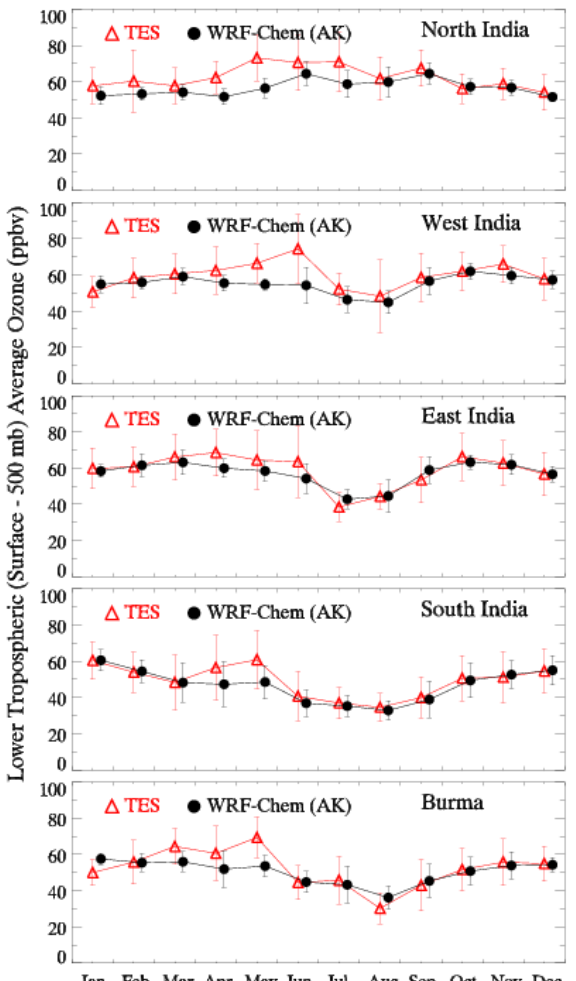
Fig. 8. Seasonal variations in WRF-Chem simulated and TES- re- Figure 8: Seasonal variations in WRF-Chem simulated and TES retrieved ozone in the lower 1313 trieved ozone in the lower troposphere (surface-500hPa) over the troposphere (surface-500 hPa) over the five regions defined in Figure 1. 1314 five regions defined in Fig.